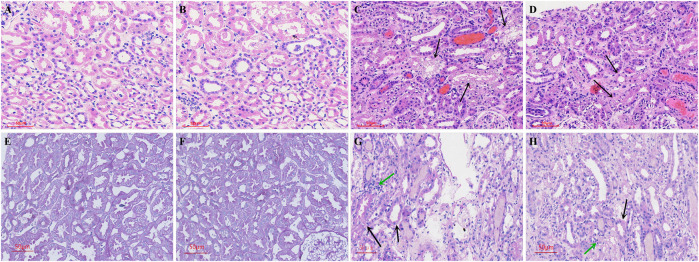
Pathological changes in kidneys from the four groups of mice. Cross-sections were stained with HE and PAS stain. HE stain: A–D. (A) Control group. (B) Ang-(1–7) group. (C) LPS group. The arrows indicate swelling of epithelial cells of renal tubules, vacuolar degeneration, and necrosis in the renal cortex and interstitium. (D) LPS + Ang-(1–7) group. Pathological damage was less severe in the LPS + Ang-(1–7) group than that in the LPS group. PAS stain: E–H. (E) Control group. (F) Ang-(1–7) group. (G) LPS group. The black arrows indicate the insoluble purple-red complex in the renal tubule cytoplasm, the green arrows indicate inflammatory cell infiltration. (H) LPS + Ang-(1–7) group. The black arrows represent the decrease of insoluble purple-red complex in the renal tubule cytoplasm, the green arrow represents reduced inflammation infiltration in the LPS + Ang-(1–7) group. Bars in A–H = 50 µm.